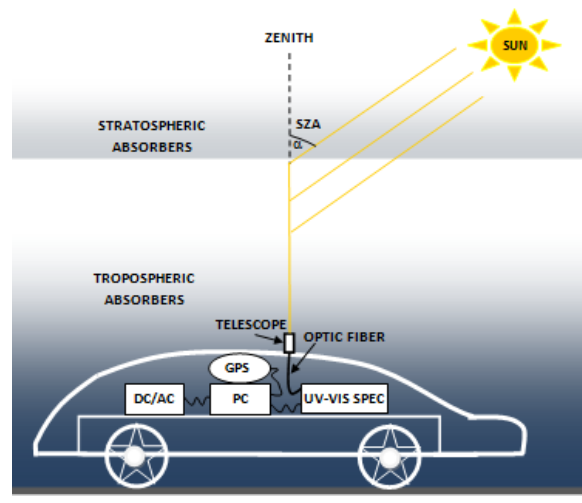
Figure 2. The mobile DOAS